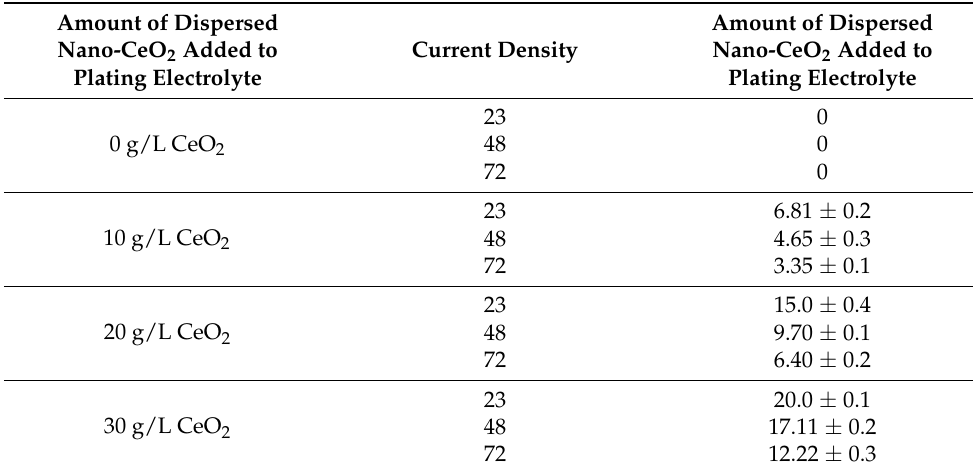
Table 2. The studied layer systems and the dispersed phase concentrations present in the obtained nanostructured layers [48].